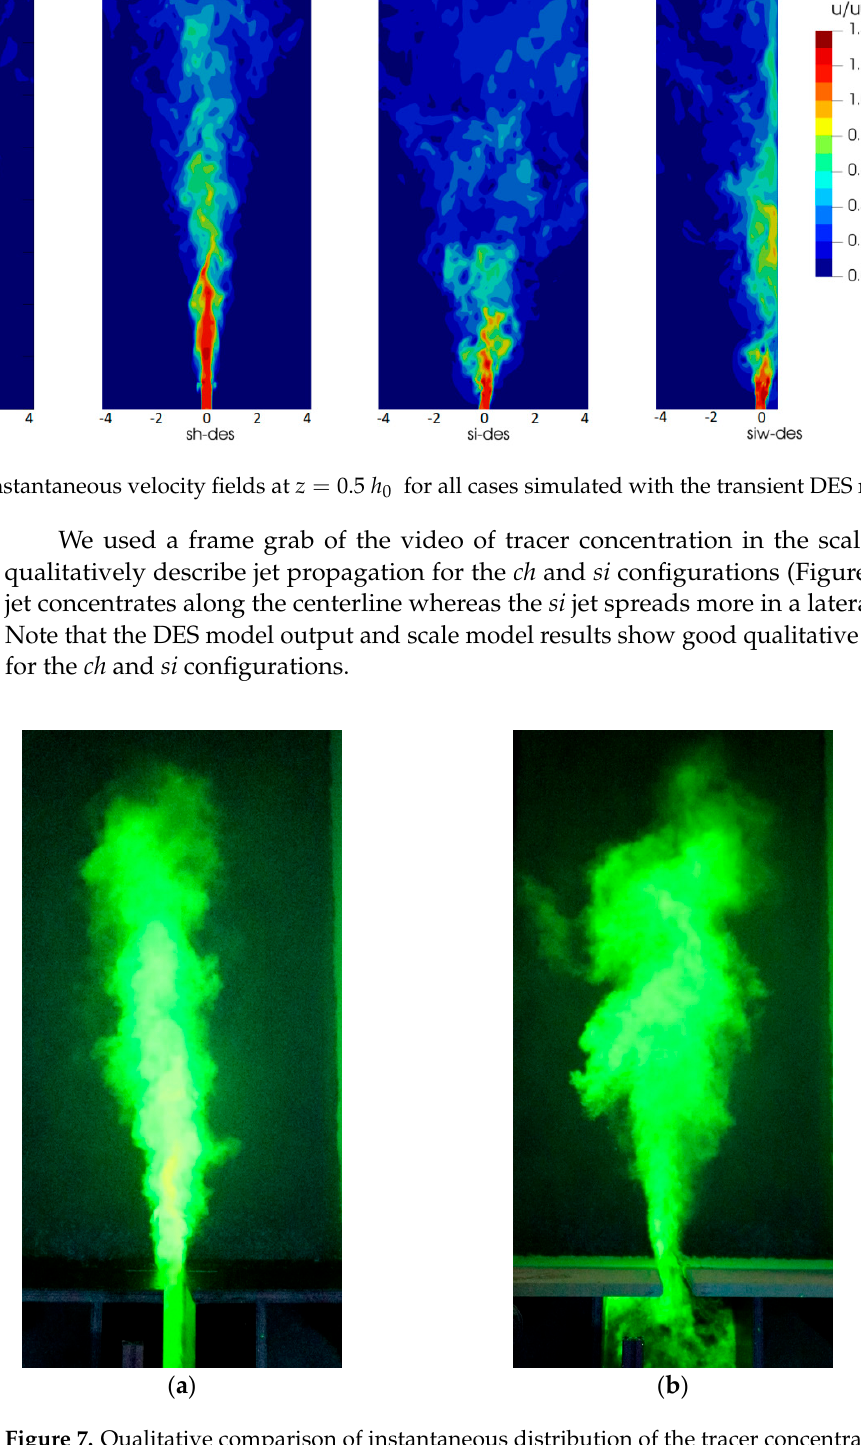
Figure 7. Qualitative comparison of instantaneous distribution of the tracer concentration of ( a ) ch and ( b ) si jet. and ( b ) si